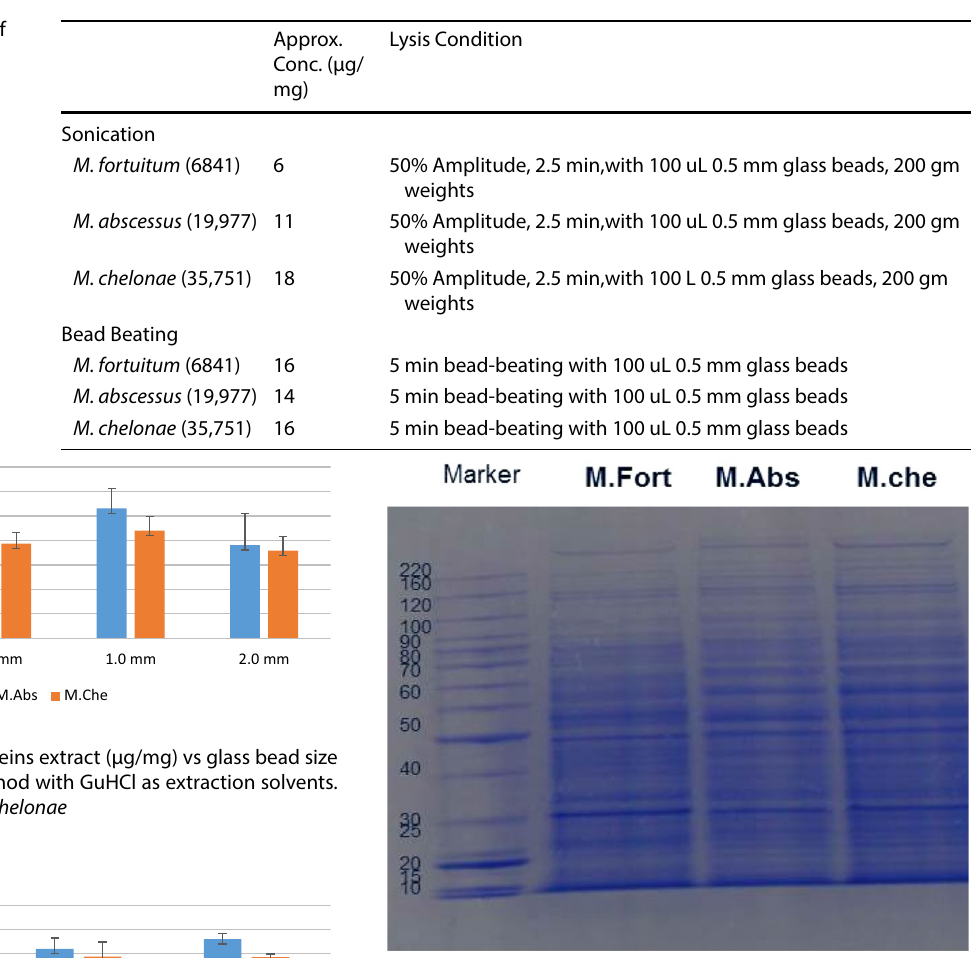
Fig. 4 (Color). Gel image of WCE of M. fortuitum , M. abscessus , and M. chelonae prepared using bead-beat lysis method with 15% ACN as extraction solvent. 25 µg proteins were loaded on 4–12%